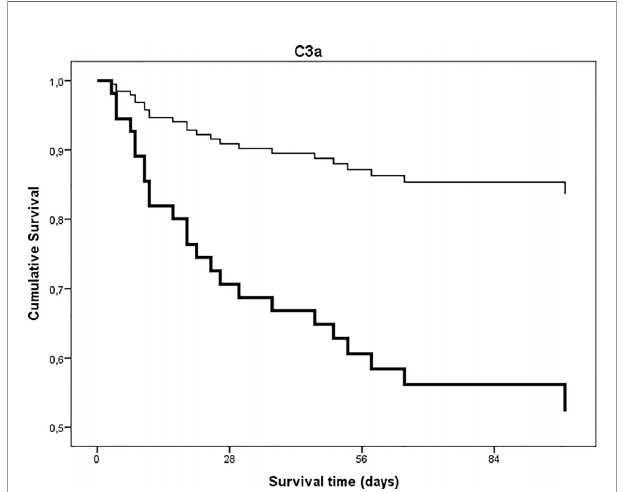
FIGURE 8 | Univariate time to in-hospital, all-cause mortality Cox proportional-hazards regression analysis in patients with COVID-19 as strati fi ed by extent of complement C3 overactivation and consumption. Patients were strati fi ed according to ratios indicating complement C3 overactivation and consumption (C3a/C3 ratio, cut point 200, p <